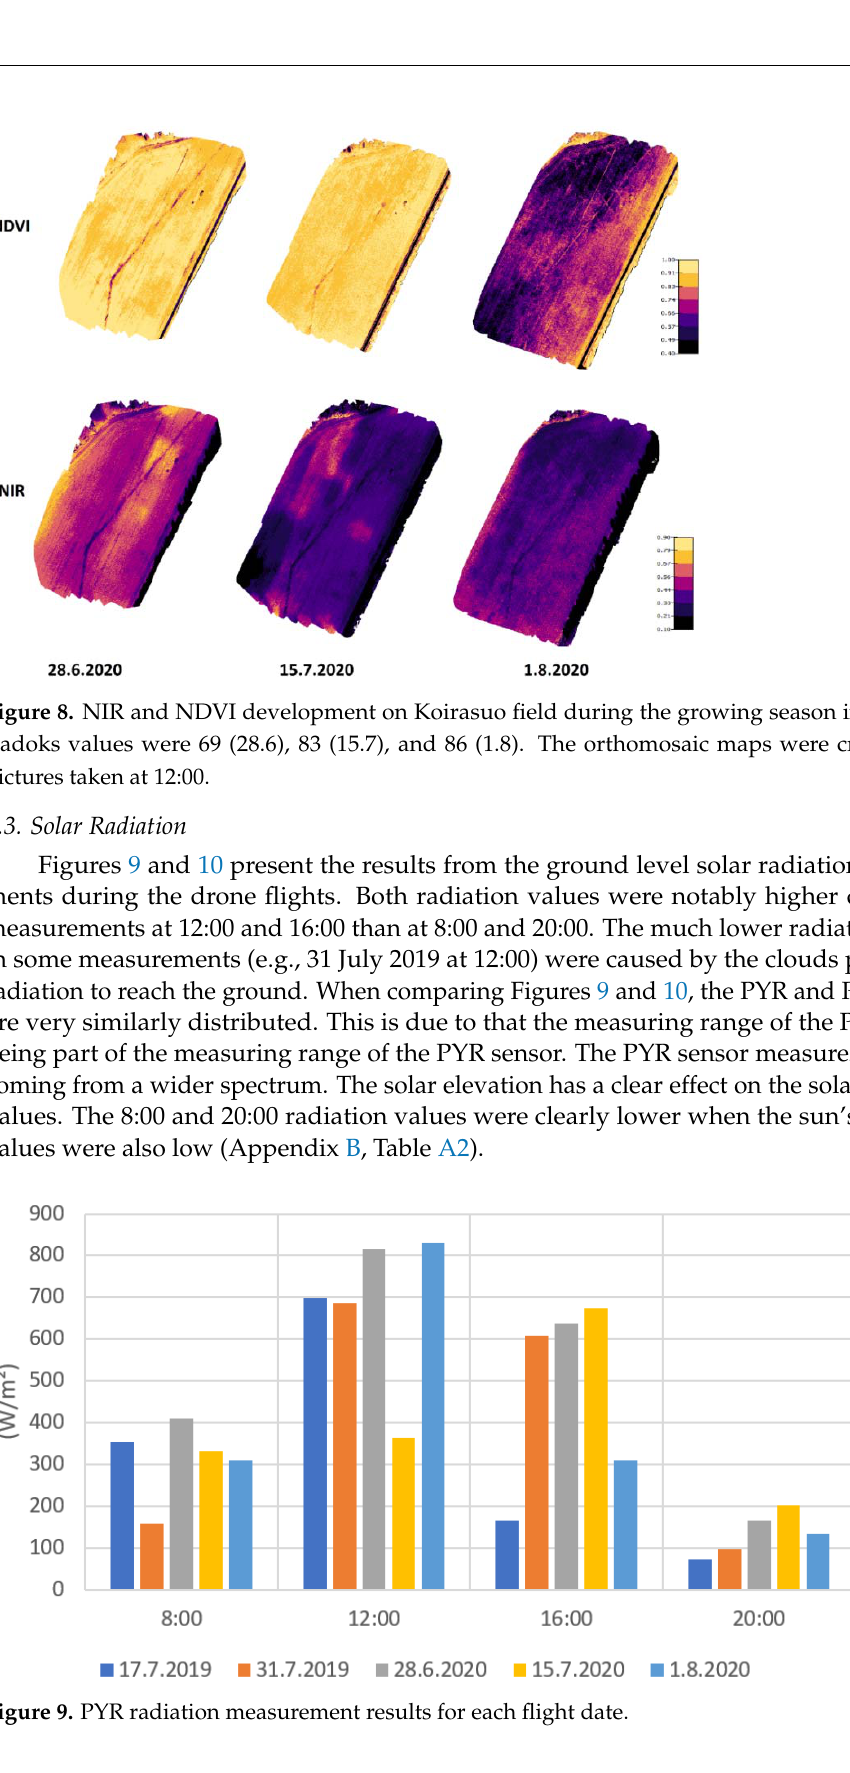
Figure 10. PAR radiation measurement values for each flight date. 3.4. Influence of the Crop on the Vegetation Indices Figure 11 presents the standard deviation values calculated between the 10 measure ‐ ment points. These results show the variations in reflectance/vegetation indices values caused by changes in the vegetation in the different areas of the field. The standard devi ‐ ation values from different spectral bands/vegetation indices cannot always be compared with each other because their maximum and minimum values can vary a lot. Based on the